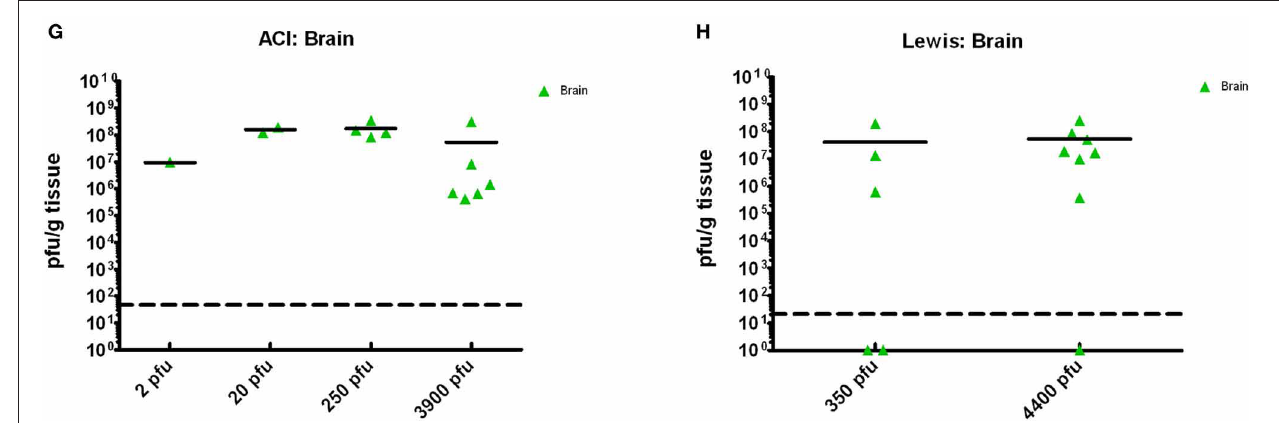
Table 3 | Comparison of disease outcome of different rat strains after subcutaneous or aerosol exposure to RVFV. Rat strain Dose (pfu) Subcutaneous* Aerosol Comparison S.C. vs. Aerosol Ave % Time to death Ave % Time to death mortality (days) mortality (days) Wistar-Furth 10 3 90 3 100 4 Severe hepatic disease; similar time frame and clinical signs ACI 10 3 10 15 100 6 Neurological disease; similar clinical signs; shorter time frame and increased lethality by aerosol Lewis 10 3 0 N/A 100 7 High lethality at modest doses by